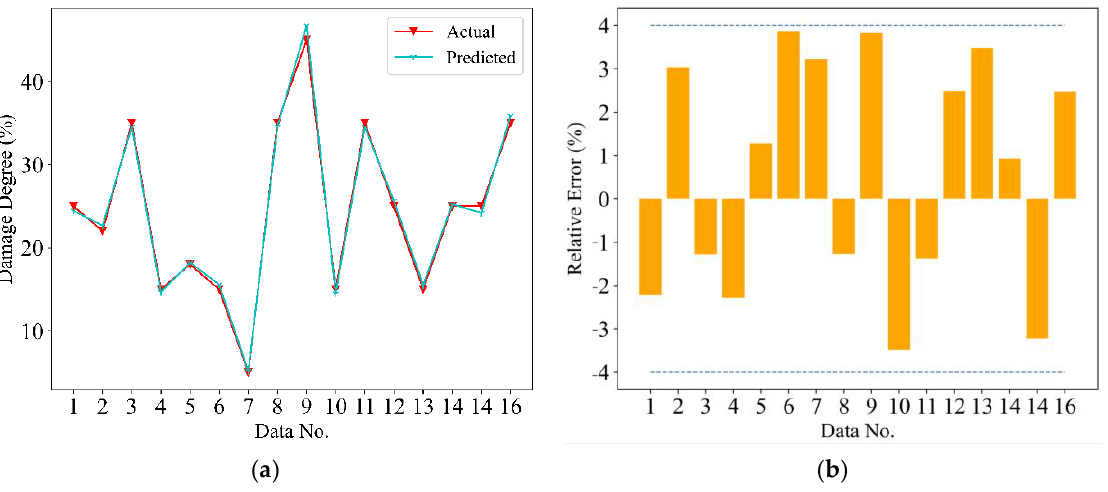
Figure 10. Comparison and RE distribution between real values and actual values of SCR damage degree. ( a ) Comparison of SCR damage degree, ( b ) RE distribution of forecasting results.